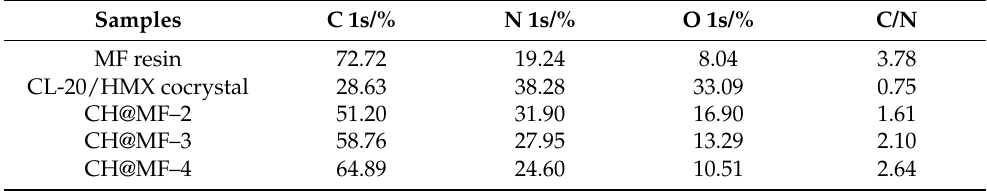
Table 2. Surface element composition of the MF resin, CL-20/HMX cocrystal and CH@MF composites.